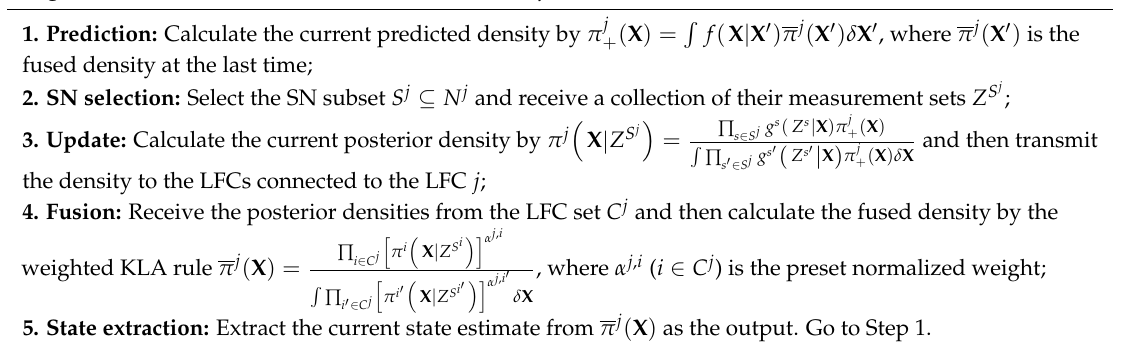
Algorithm 1. Sensor selection and MTT for the LFC j